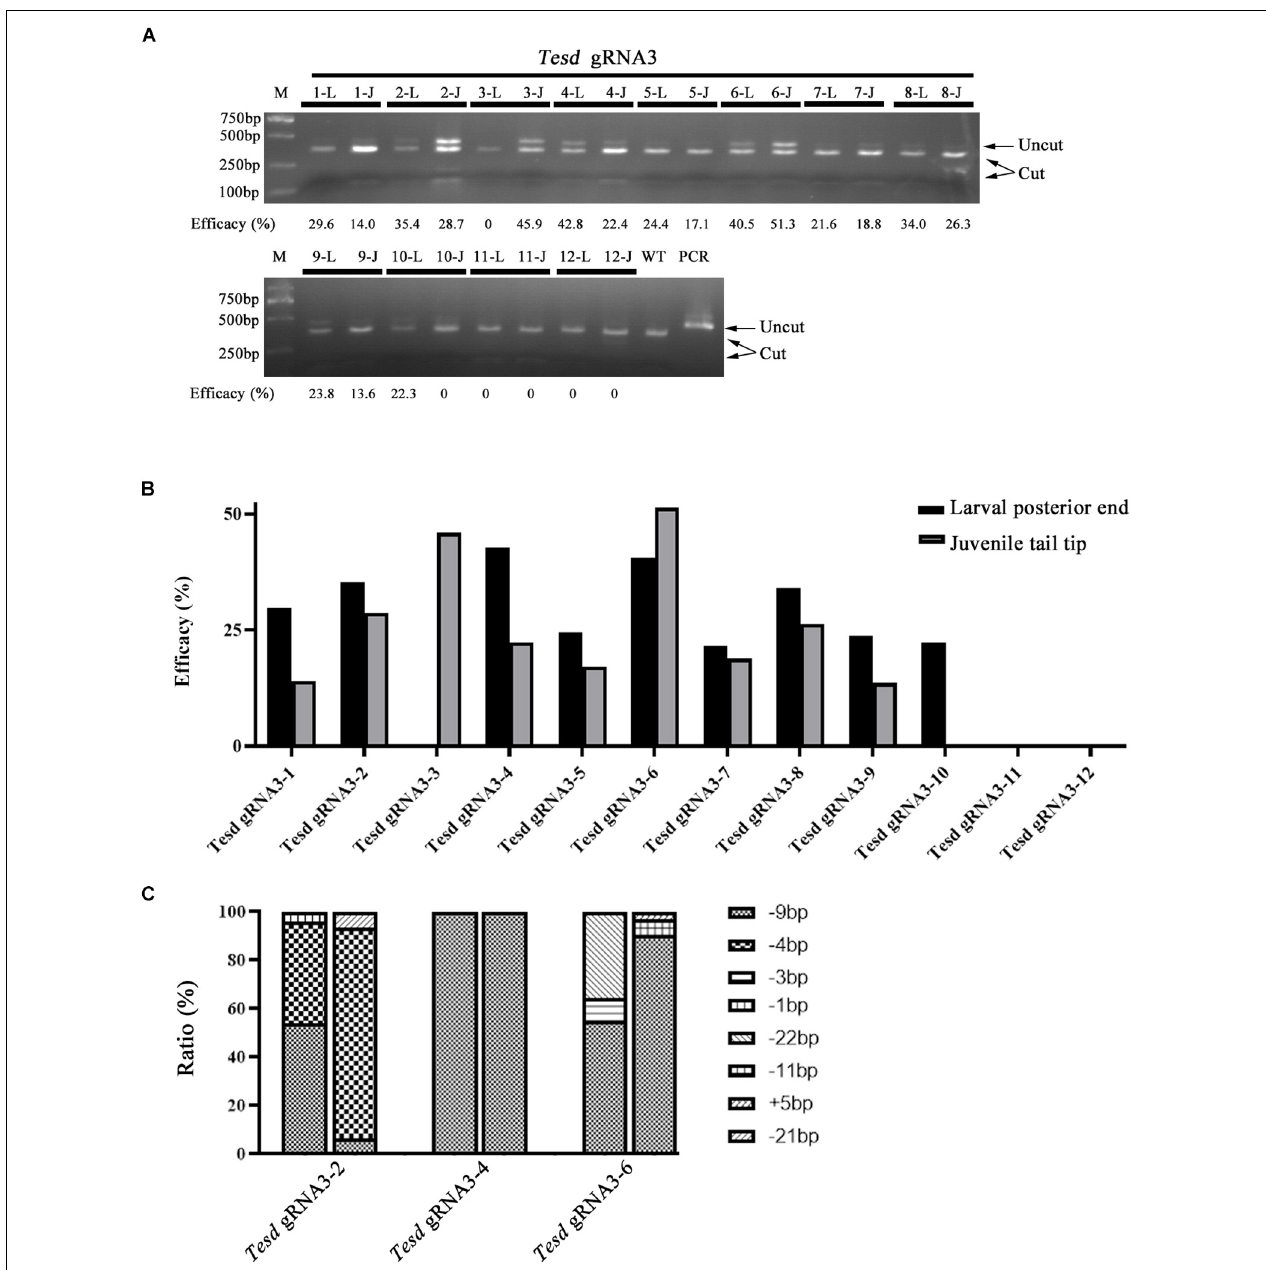
FIGURE 5 | Mutation efficacy and type detected in posterior ends of 4-gill-slits larvae and their tail tips after metamorphosis. (A) Mutation efficacy detection by restriction enzyme assay. Twelve F0 individuals injected with Cas9 protein and Tesd gRNA3 were examined. The induced mutation efficacies (estimated as percentages of uncut PCR products) are labeled under the gel image. L represents efficacy detected in the posterior end of each individual at the larval stage, and J represents efficacy detected in their tail tips at the juvenile stage. (B) Graphic view of the mutation efficacies shown in A . (C) Mutation types detected in the posterior ends and tail tips of three F0 individuals (#2, #4, and #6). For each individual, the first column represents mutation types detected in the posterior ends and the second column represents those detected in the tail tips. Each type of mutation is marked with a different